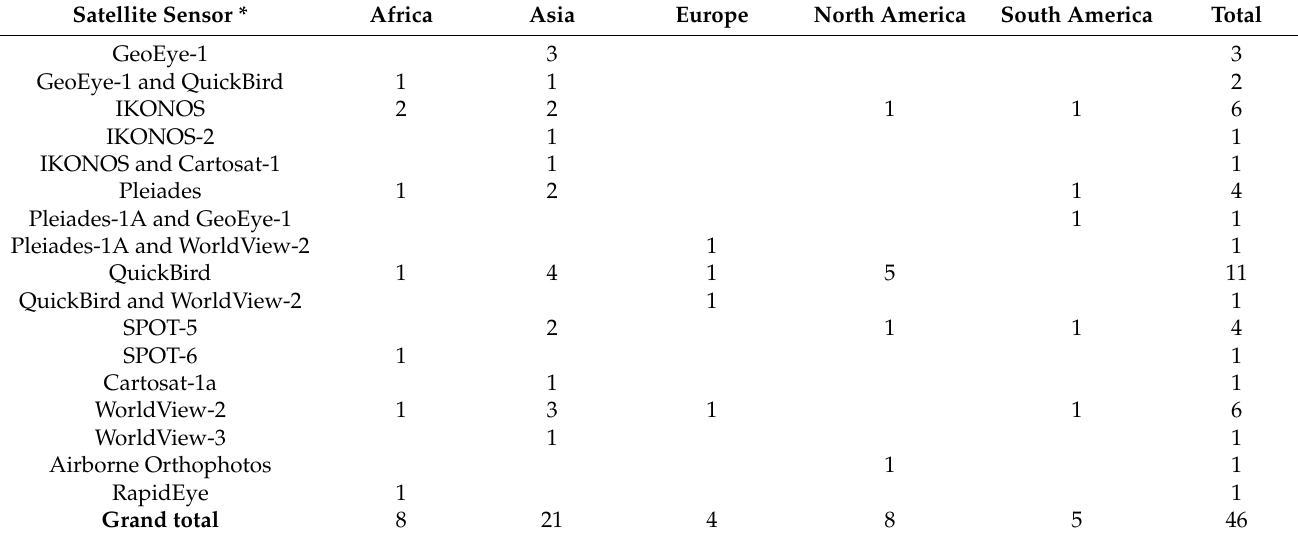
Table 1. A synthesis of 30 published peer-reviewed articles (2004–2019) at continent level—optical high-resolution satellite data used for AGB estimation and